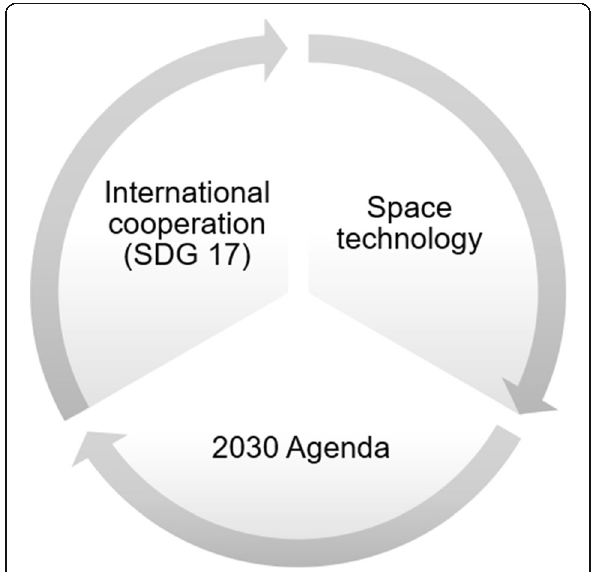
Fig. 13 Schematic representation of the circular interaction between the 2030 Agenda, international cooperation (SDG 17) and the development of space